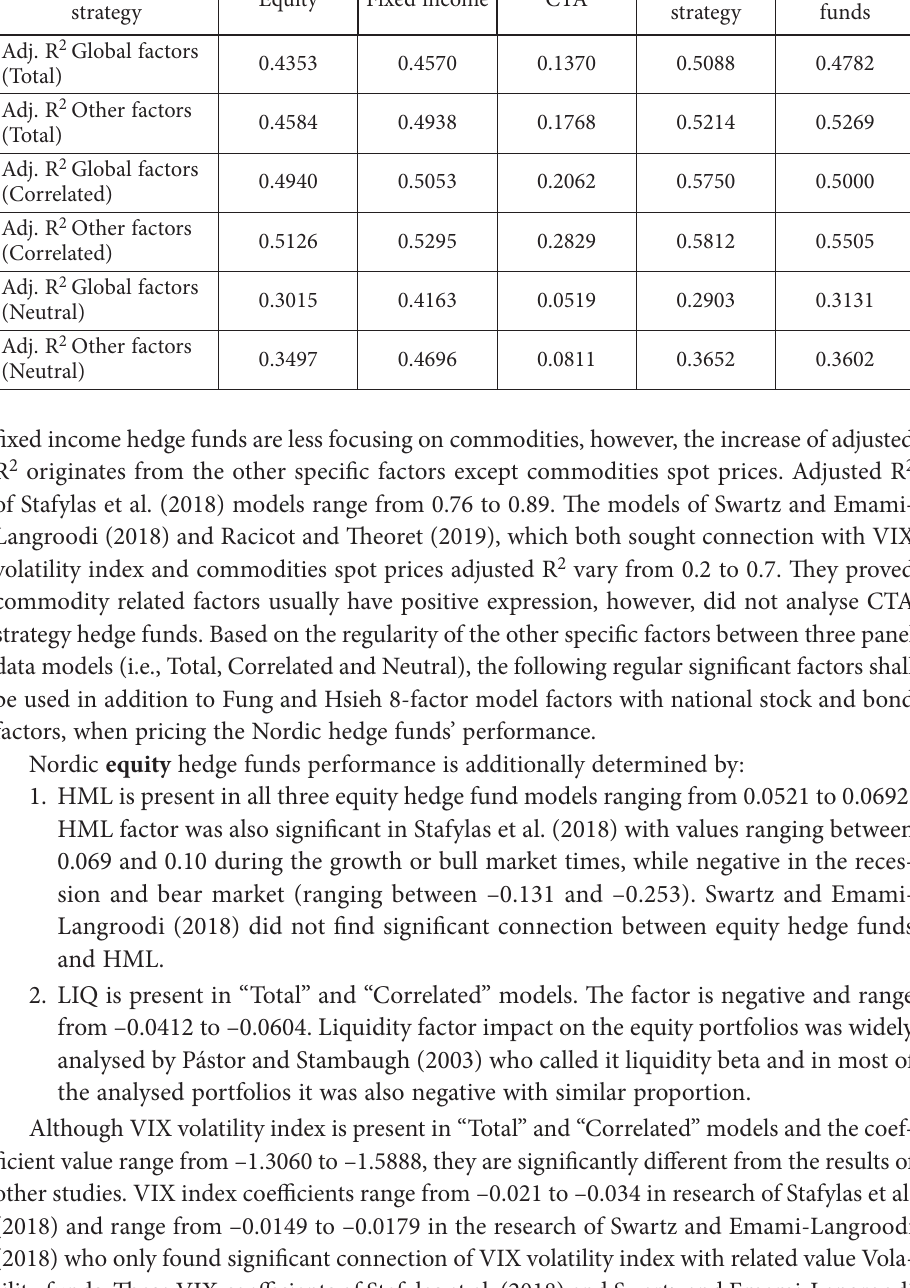
Table 11. Nordic hedge fund panel data global and national models’ comparison Nordic hedge fund